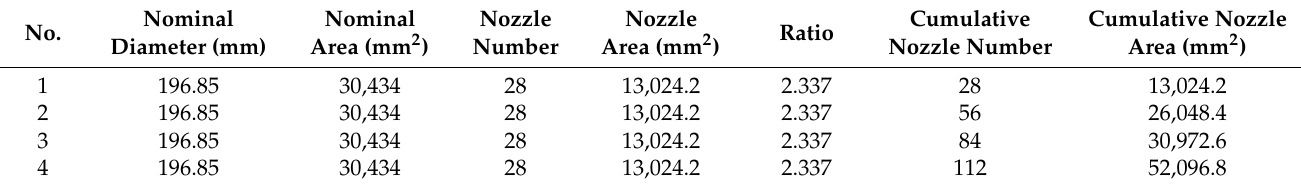
Table 1. Main structural parameters of governing valve and governing